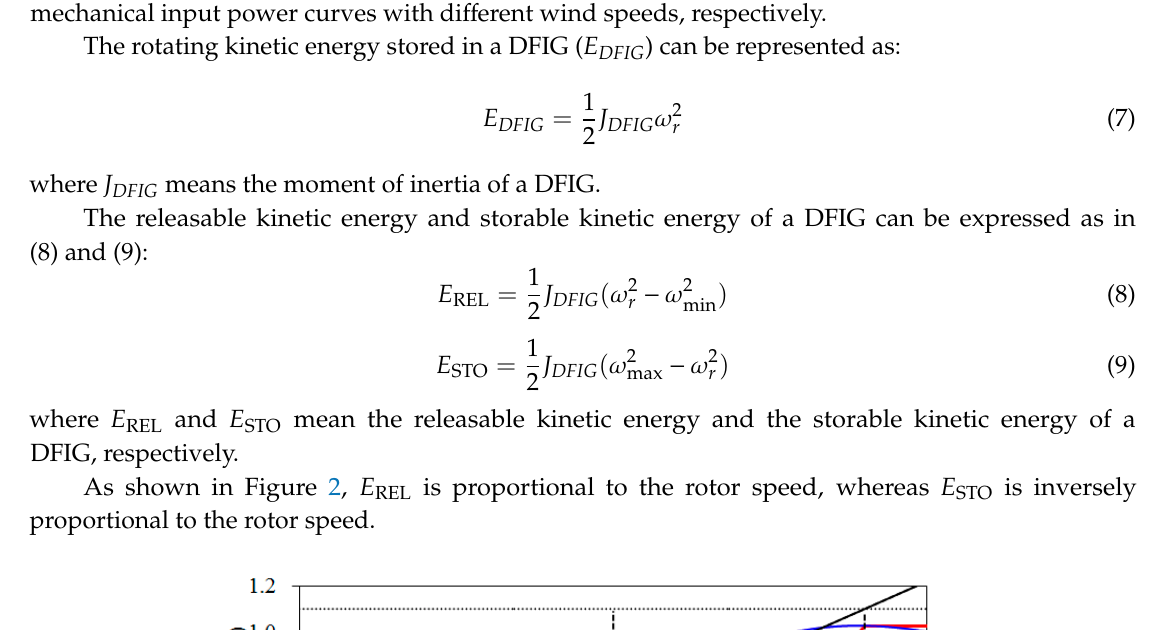
Figure 1. Doubly-Fed Induction Generator configuration. Figure 2 indicates the power characteristics of the DFIG used in this study. The black dashed lines of Figure 2 reflect the ω r operating range of a DFIG, which is from 0.70 p.u. (corresponds to ω min ) to 1.25 p.u. (corresponds to ω max ). The red solid line and blue line indicate the MPPT curve and